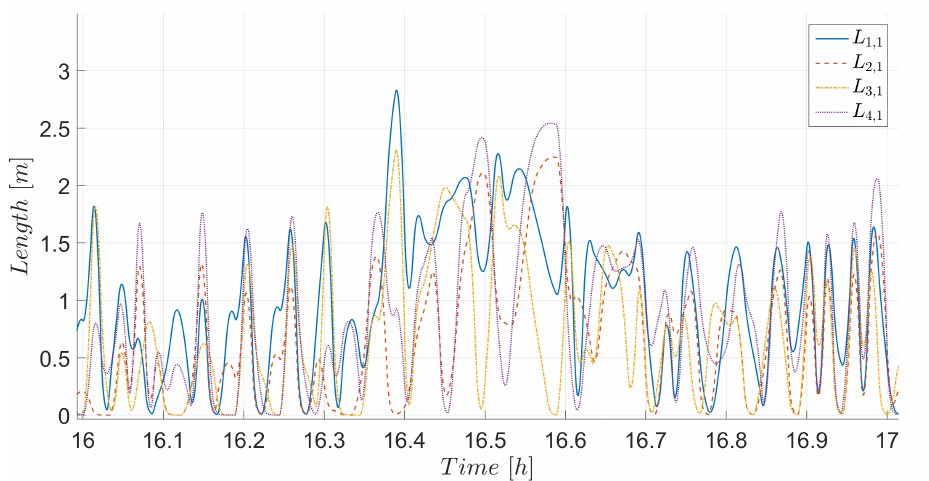
Figure 10. Zoomed-in view of the DMD lengths applied to the chaser spacecraft. Interval between 16 and 17